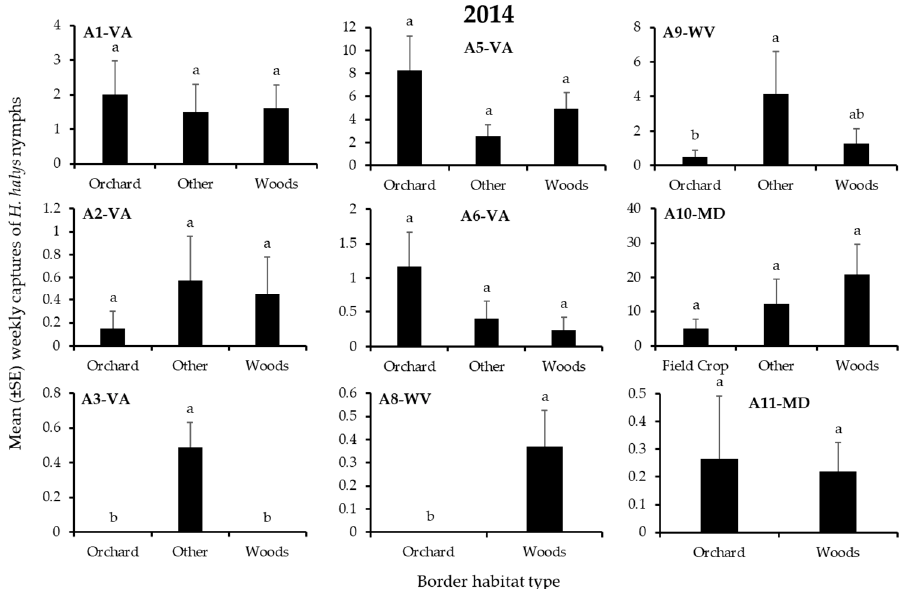
Figure 3. Mean (± SE) weekly captures of H. halys NYMPHS in pheromone-baited traps on the perimeter of 9 apple orchard blocks in the Mid-Atlantic, USA, from 7 April to 17 October 2014. Bars with shared letters are not significantly different (Tukey HSD, α = 0.05).